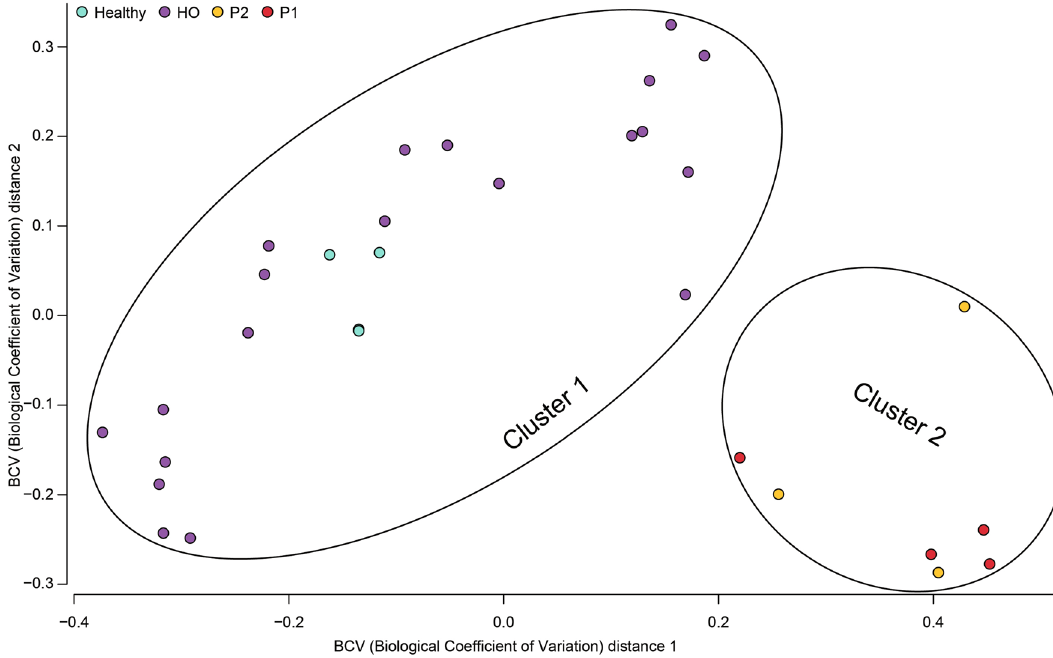
Figure 4. Multidimensional scaling (MDS) plot representing healthy controls (H) and HO patients diagnosed with (HO-proven, HO-probable) or without (HO-possible) IA. Red and orange circles represent proven and probable IA, gray circles represent healthy controls (H), and blue circles represent non-IA HO patients (possible IA). On the basis of distance matrices, the healthy controls and non-IA HO patients clustered together, and the IA-infected patients formed distinct